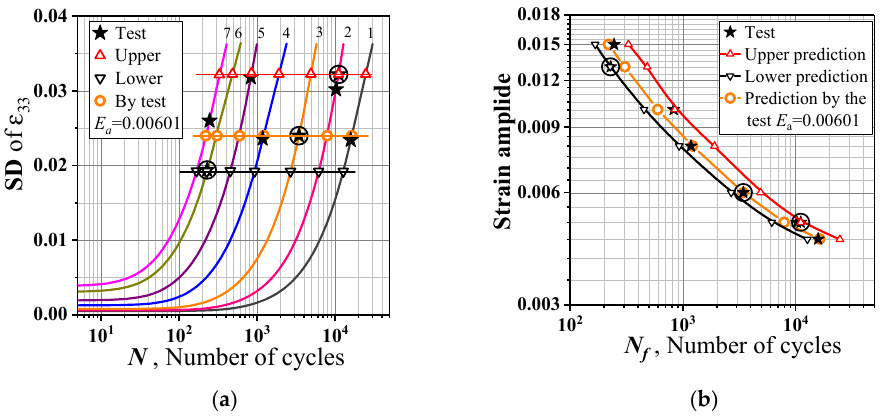
tests. N E ; ( b ) predicted fatigue–life curves and their comparison with mining point sequences predict ( , ) f a Figure 9. Verification of FIP ˆ ε 33 ( E a ) : ( a ) determining upper and lower of critical value and de-